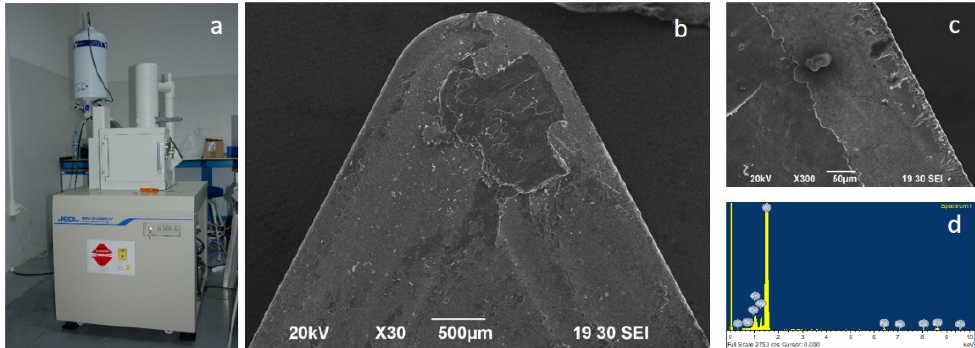
Figure 4. SEM and EDS equipment: ( a ) scanning electron microscope; ( b ) tool rake face SEM image; ( c ) cutting edge SEM image; ( d ) EDS Spectrum.